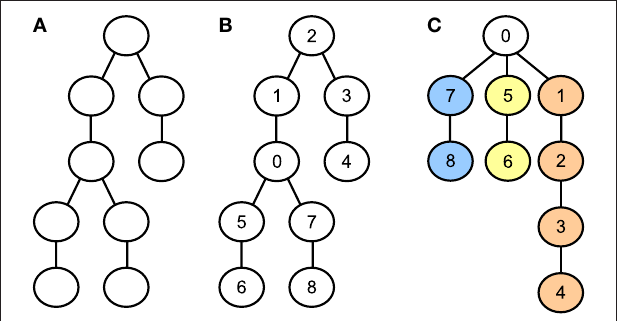
FIGURE 8 | (A) Yet unnumbered tree-shaped graph representing the connectivity of some neuron. (B) Same graph, numbered such that the largest subtree connected to the root compartment (compartment 0) is as small as possible. (C) Same graph and numbering as for the middle graph, but restructured and colored to emphasize the distinct subtrees that may be solved in